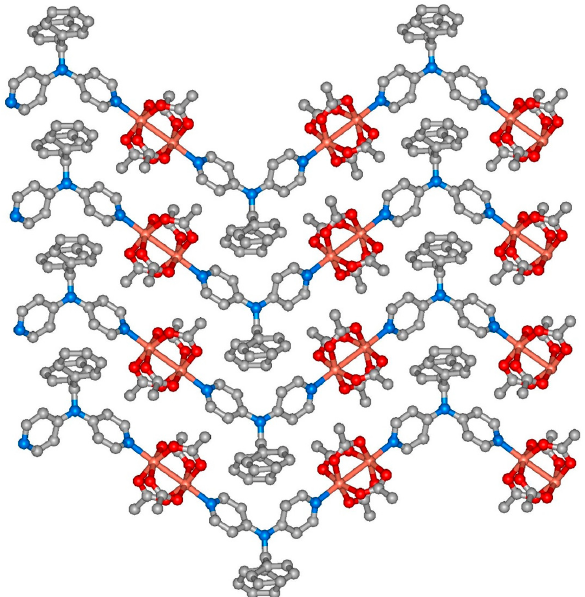
Figure 4. Extended 2D structure of polymer 1 displaying the π – π interactions through the benzyl and pyridine groups between the 1D chains. Both positions of the disordered benzyl group are shown, each in a 50% proportion.